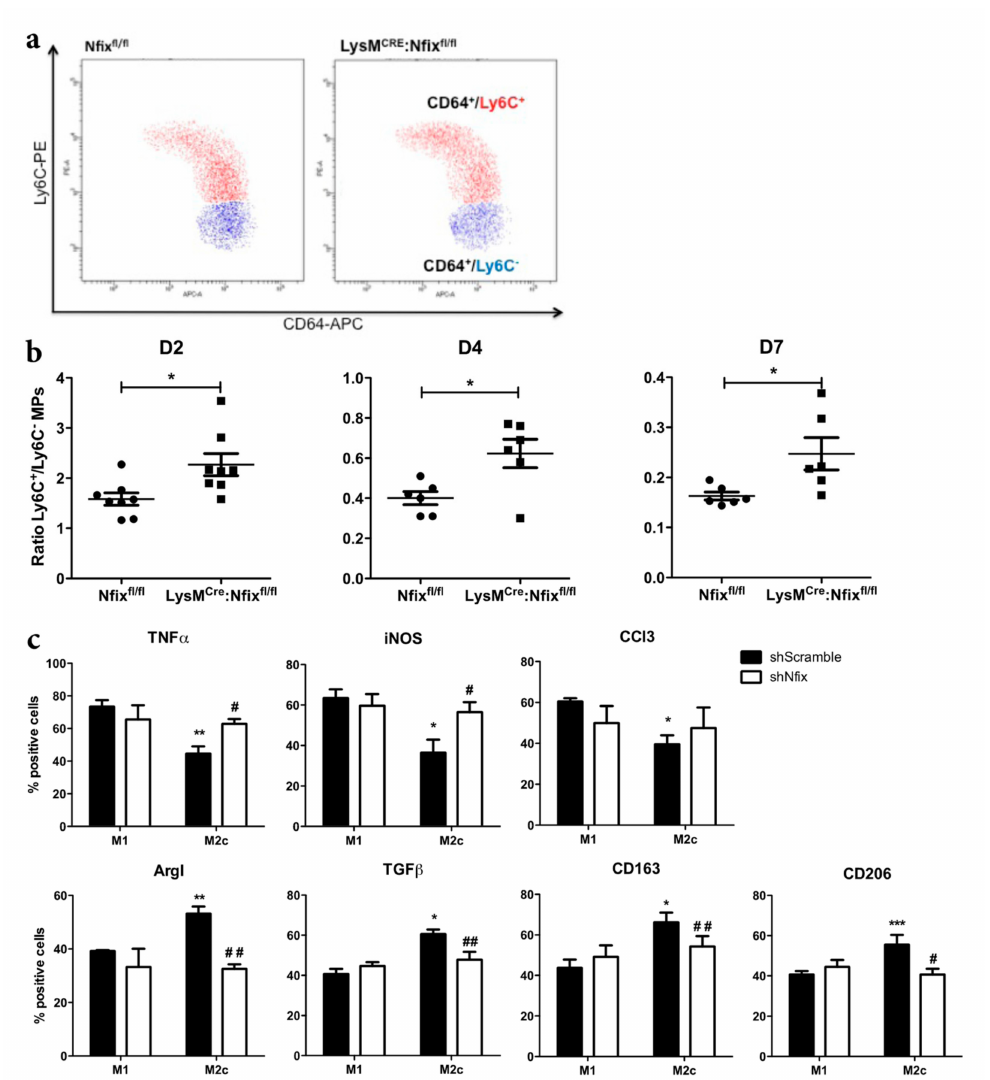
Figure 3. MPs lacking Nfix are unable to adopt an anti-inflammatory phenotype in vivo and in vitro. ( a ) Representative FACS (Fluorescence-Activated Cell Sorting) gate of pro- and anti-inflammatory CD64 + MP populations in TA of Nfix fl / fl and LysM CRE :Nfix fl / fl mice at D2 after CTX injection. (CD64 + / Ly6C + and CD64 + / Ly6C − respectively); ( b ) Ratio of Ly6C +/ Ly6C − MPs sorted from TA of Nfix fl / fl and LysM CRE :Nfix fl / fl mice at D2, D4 and D7, after CTX injection; ( c ) WT BMDM (Bone